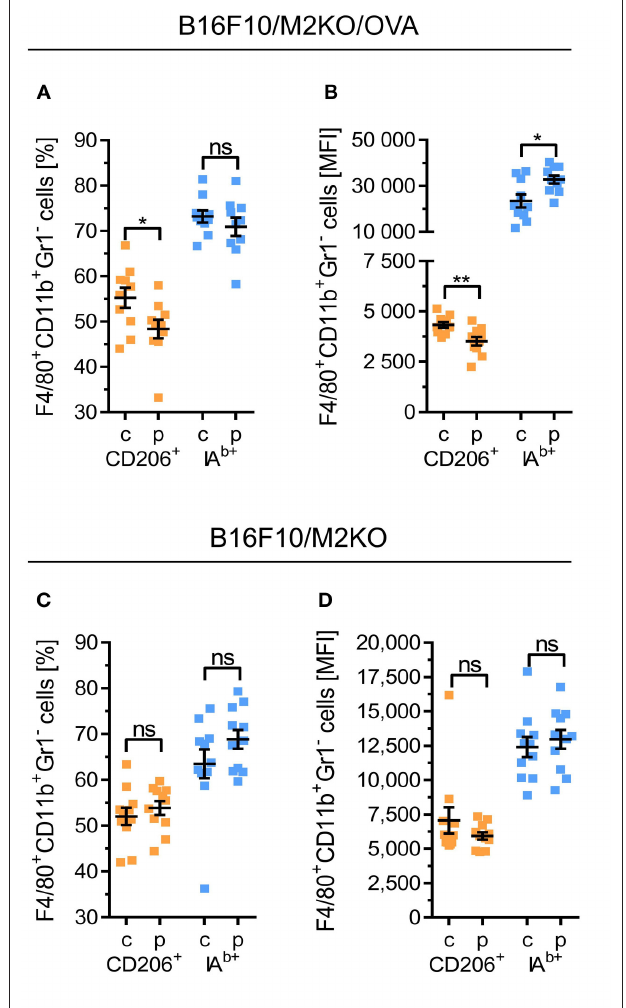
FIGURE 5 | Adoptive transfer of OVA-specific CD4 + T cells repolarizes TAM phenotypes in B16F10/M2KO/OVA tumors. C57BL/6 Ly5.1 mice ( n = 10–11) were injected s.c. either with 2 × 10 5 B16F10/M2KO/OVA cells (A,B) or with OVA negative B16F10/M2KO cells (C,D) . After 10 days, mice bearing tumors of equal size were injected i.v. with 5 × 10 6 peptide primed OT-II cells (p) or were left untreated (c), followed by flow cytometric analysis of tumor infiltrating immune cells on day 14. Frequencies of CD206 + and IA b positive TAMs (F4/80 + CD11b + Gr1 − ) (A,C) as well as cell surface expression levels of CD206 + and IA b molecules (B,D) are depicted. Error bars represent SEM within each animal collective. Gating strategy: CD45 + → living cells → single cells (FSC-A vs. FSC-H) → F4/80 + CD11b + Gr1 − → CD206 vs. IA b . Statistical analysis was done by unpaired Student’s t -test (95% CI, ns: not significant, * p ≤ 0.05, ** p <